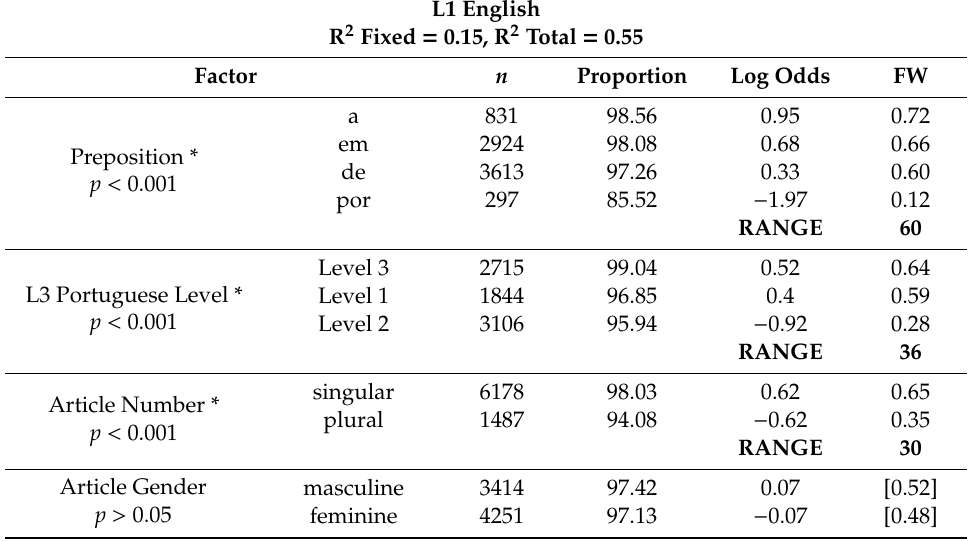
Table 9. Logistic regression of factors conditioning the realization of obligatory preposition + article contraction in L3 Portuguese for L1 English speakers.